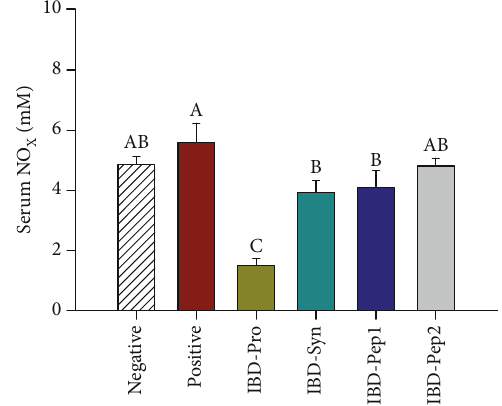
Figure 1: Serum nitric oxide (NO) concentration. A,B Values are signi fi cantly di ff erent ( p < 0 : 05